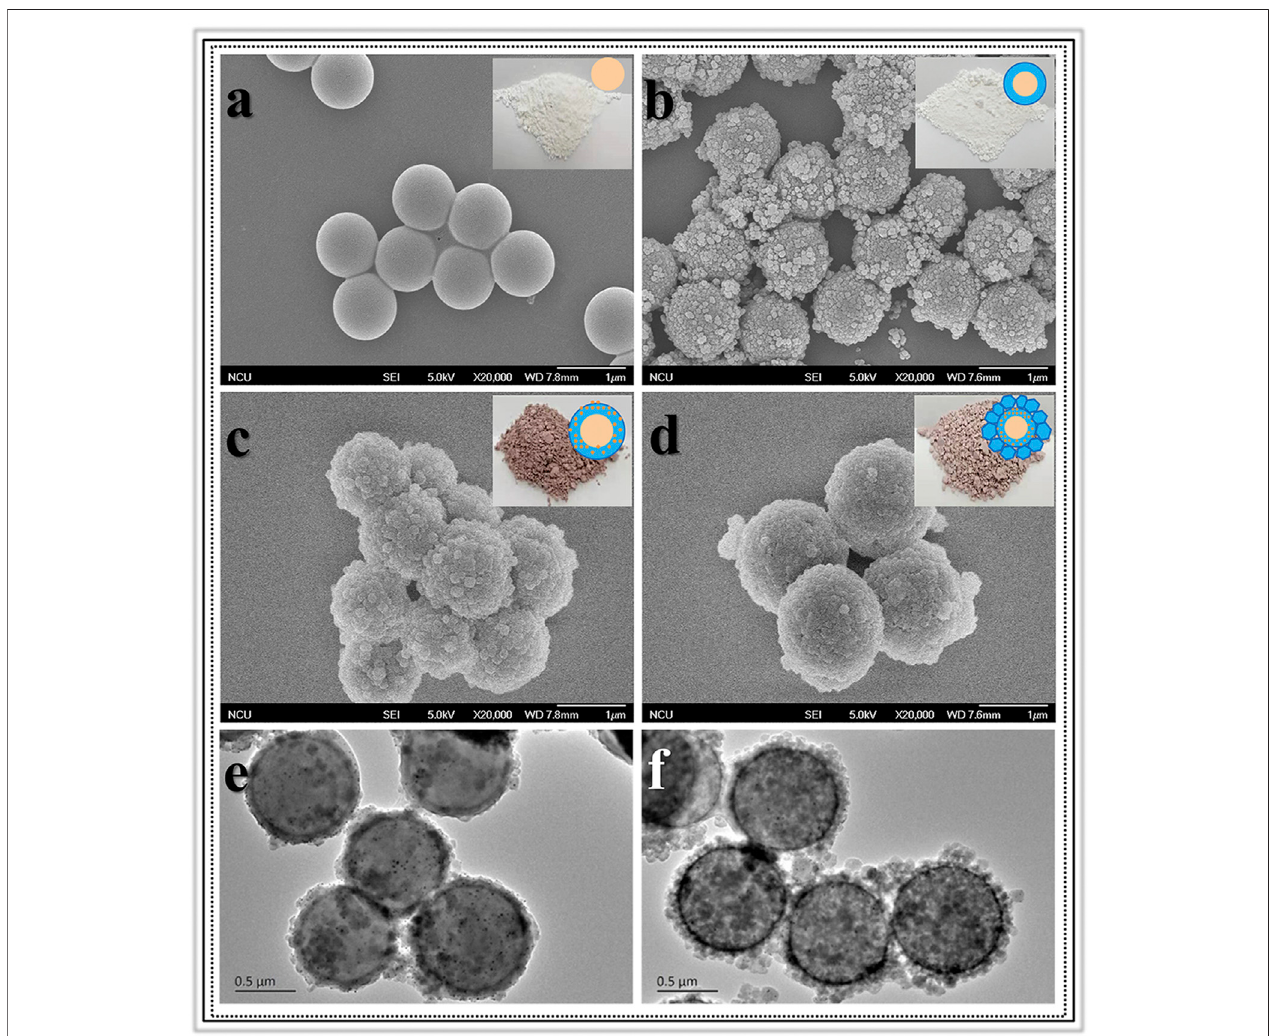
FIGURE 2 | Images of SEM for (A) SPS; (B) SPS|ZIF-8; (C) SPS|(Au)ZIF-8; (D) SPS|(Au)ZIF-8|ZIF-8 and TEM for (E) SPS|(Au)ZIF-8; (F) SPS|(Au)ZIF-8|ZIF-8.